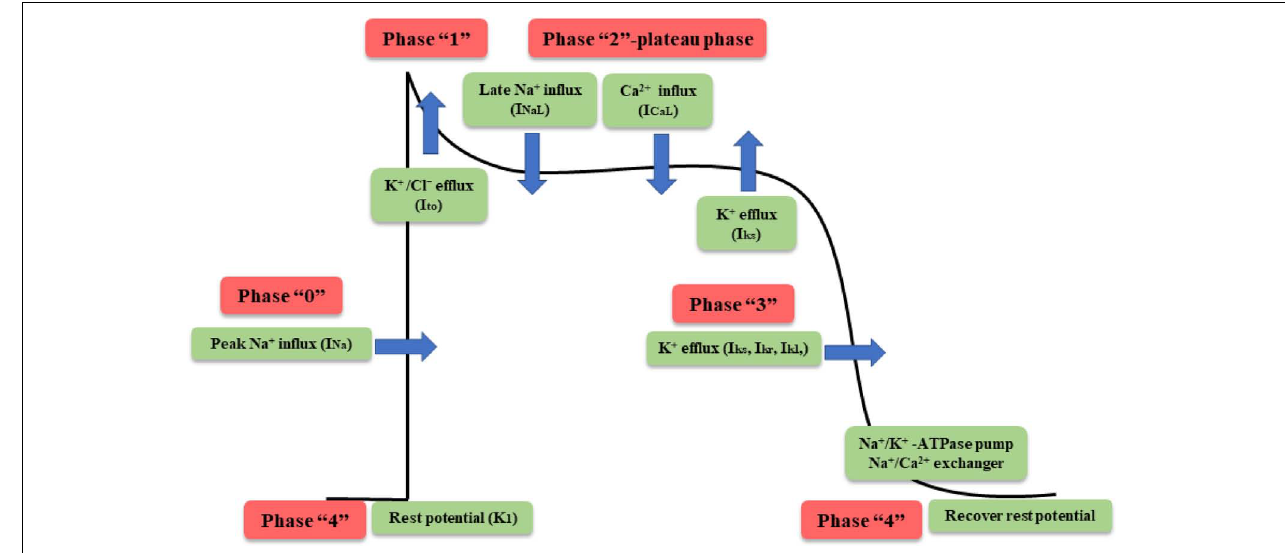
FIGURE 4 | Phases of cardiac action potential in nonpacemaker